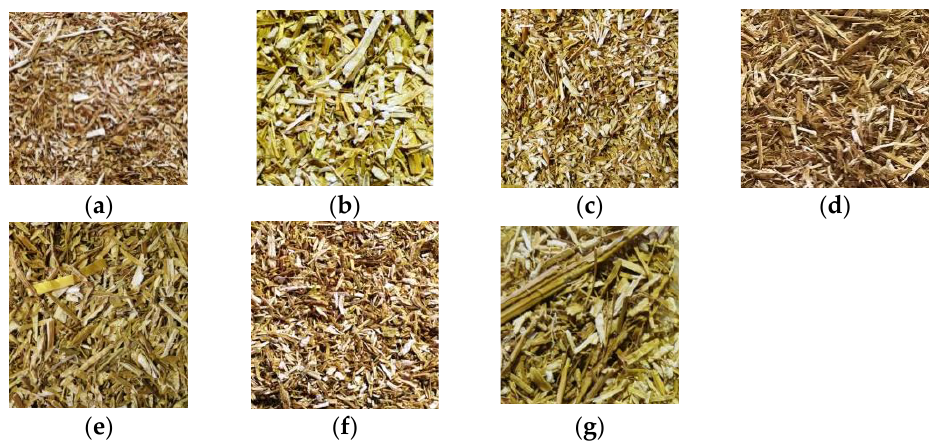
Figure 1. Rapeseed straws from: ( a ) — Marne 15-10, ( b ) — Marne15-20, ( c ) — Marne 16-10, ( d ) — Marne 16-20, ( e ) — Somme 16-10, ( f ) — Somme 16-20, ( g ) — Marne 16-20 Impact.